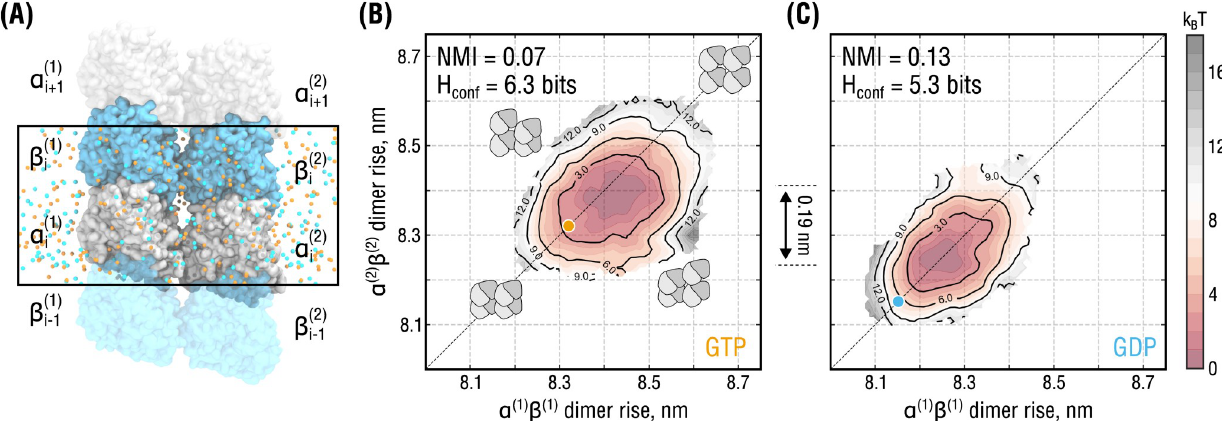
Fig 3. Lateral coupling and nucleotide state affect PF dynamics. (A) , Simulation setup for the double-PF system mimicking a standard (homotypic) lateral interface. Color coding as in Fig 2A. Water molecules are hidden for clarity. Periodic box is marked by a black rectangle. Individual PFs are labeled as (1) and (2). (B) and (C) , Free energy surfaces of the system in (A) as a function of dimer rise and nucleotide state obtained by umbrella sampling. The surfaces are color-coded by free energy values with an increment of 1 k B T (dark red to gray). Black solid lines additionally show isoenergetic contours. Orange and cyan circles indicate the dimer rise values observed in the cryo-EM densities of GMPCPP- and GDP-MTs, respectively. Cartooned dimers in (B) schematically show the extreme conformations of the double-PF system in which both are similarly expanded or compacted (along the diagonal) or in conflicting conformations (along the anti-diagonal). The relative shift of 0.19 nm between the minima of the free energy sufraces in (B) and (C) is additionaly indicated.